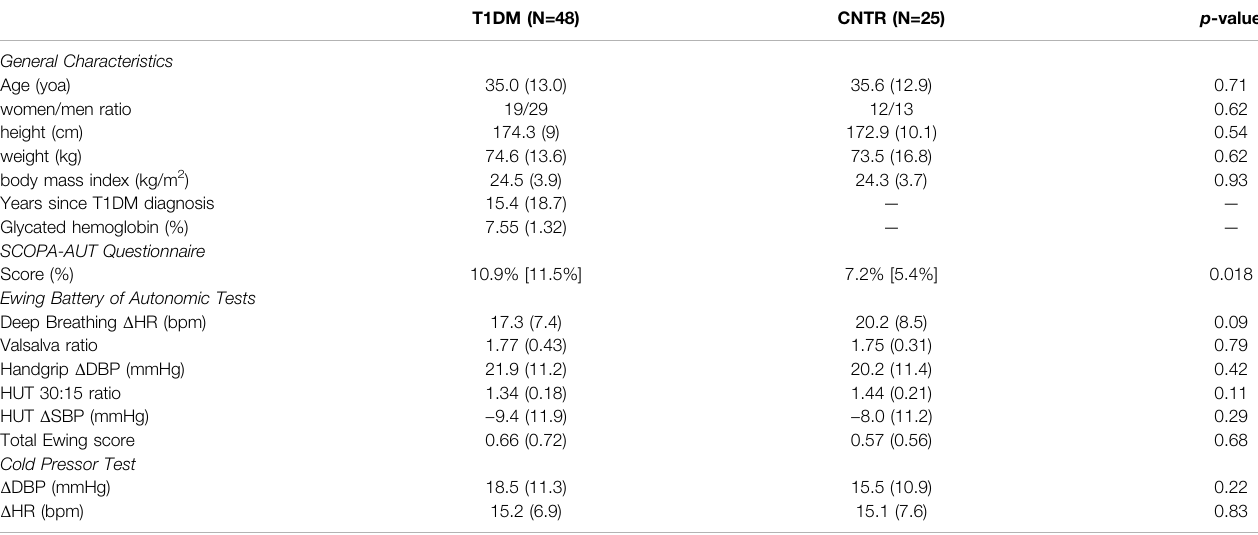
TABLE 1 | General characteristics and outcomes of the autonomic function tests in T1DM and CNTR groups: mean (SD) or median [IQR] with statistical signi fi cance of the difference between groups. T1DM